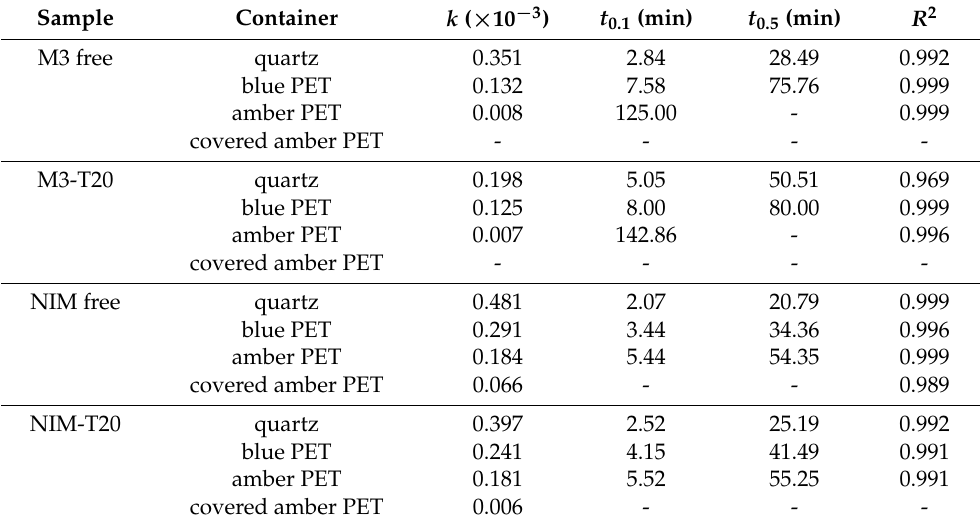
Table 1. Degradation kinetic parameters calculated for M3 and NIM